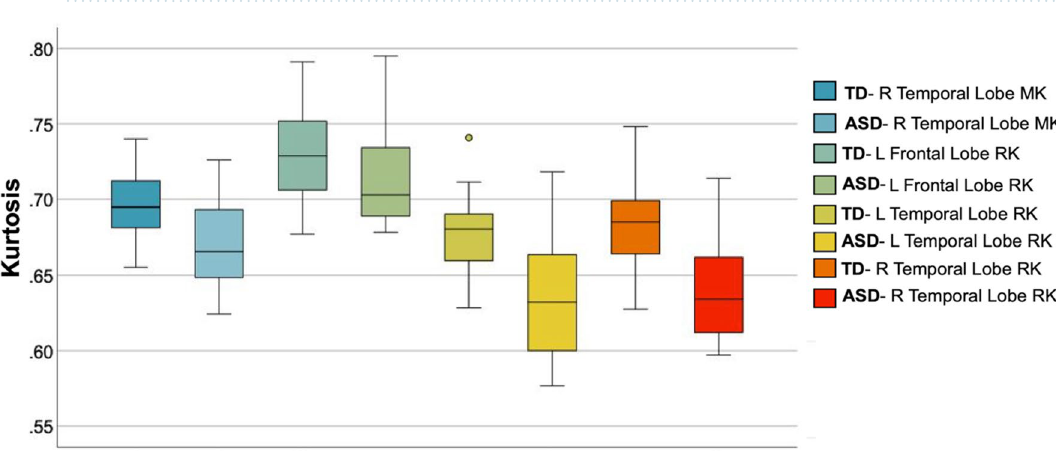
Table 2. Differences in diffusion metrics (MK, RK and MD) in autism spectrum disorder compared to typical developing young adults in the frontal, temporal and parietal lobes and sub-lobar gray matter regions-of- interest in the brain revealed through ANCOVA analysis controlling for age. All tests shown reach trend- level at p ≤ 0.05, uncorrected; tests that remain significant after the BH procedure for multiple comparisons correction at q ≤ 0.05 are indicated by an asterisk (*) along with the effect size (Cohen’s d).